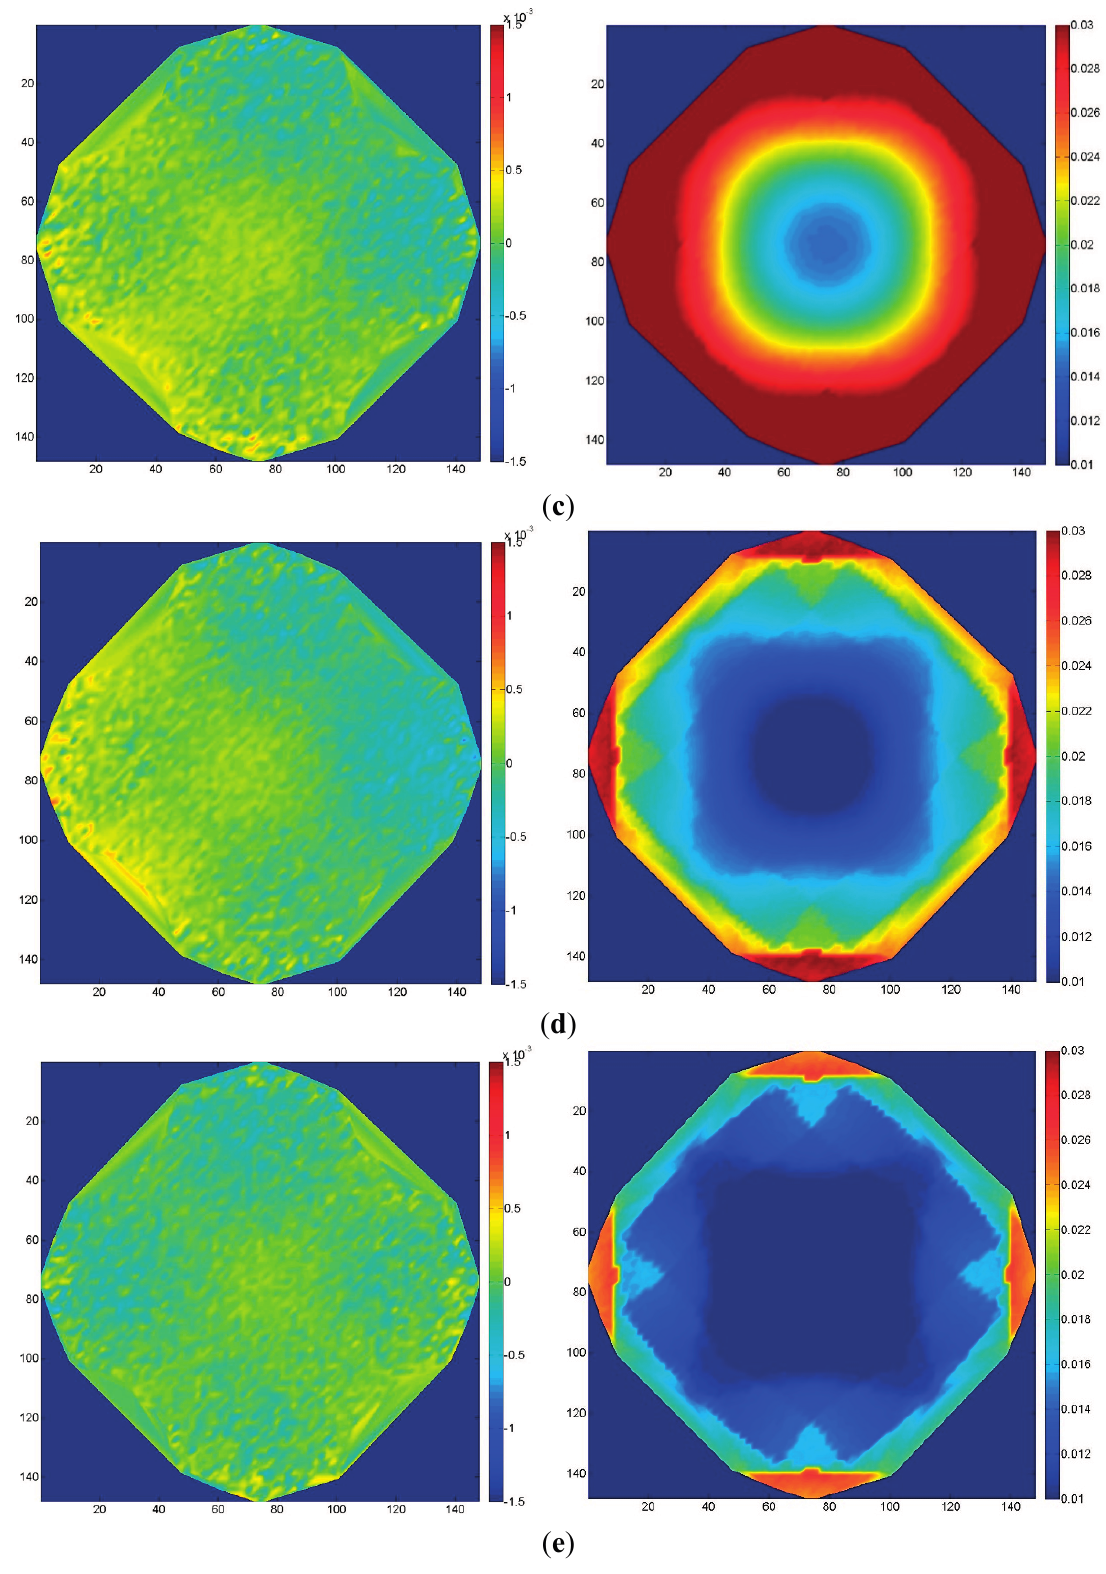
Figure 11. Case 4, circular block: errors due to varying GCP accuracy. Left column: mean error; right column: standard deviation of the error. From top to bottom, the GCP accuracy, expressed in terms of GSD, improves. ( a ) 10 GSD; ( b ) 5 GSD; ( c ) 2 GSD; ( d ) 1 GSD; ( e ) 0.5